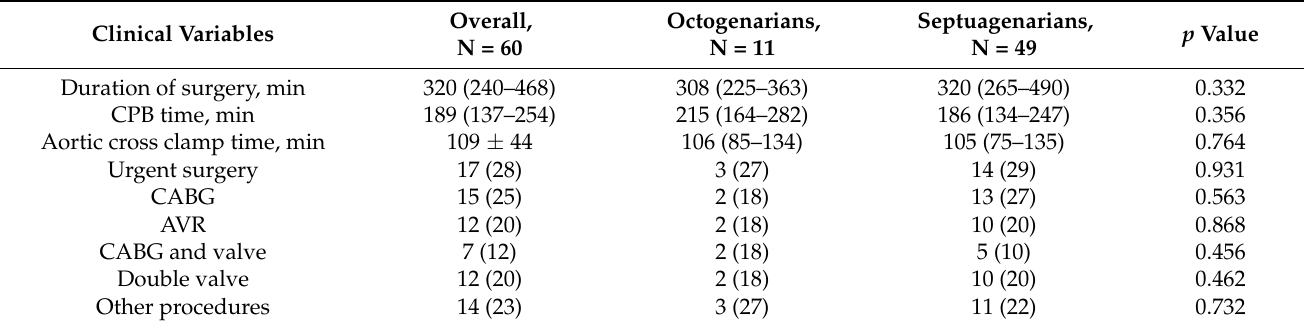
Table 2. Type of surgical procedures and perioperative data.